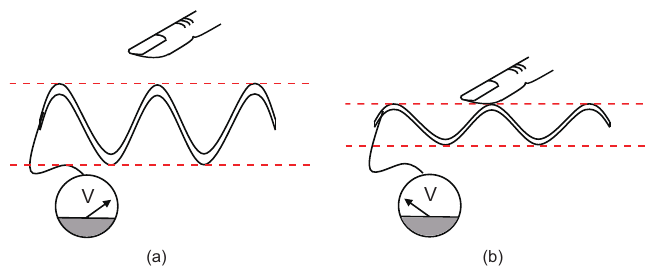
Figure 1. Proposed static tactile sensing method. ( a ) When no external contact is made, the piezoelec- tric membrane, driven oscillating with constant amplitude, generates the voltage signal. ( b ) When external contact is made, this will suppress the vibration amplitude of the membrane, resulting in a smaller piezoelectric voltage signal compared to the value at contact-free oscillation. By monitoring this change in the piezoelectric output signal, the presence of the external contact can be